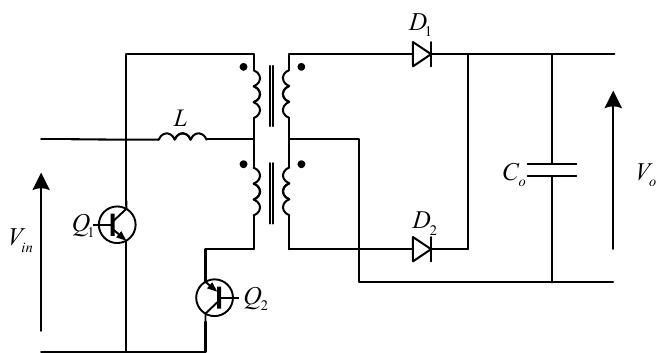
Figure 7. Circuit diagram for the current fed push pull boost converter.